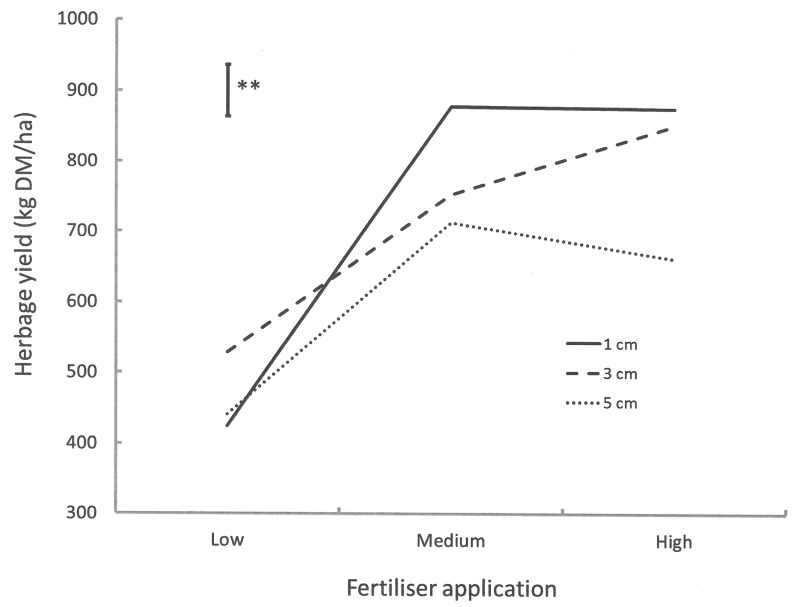
Interaction between P fertiliser and defoliation treatments on the herbage yield of M. ruthenica.Bar represents the standard error of the mean; **P < 0.01.